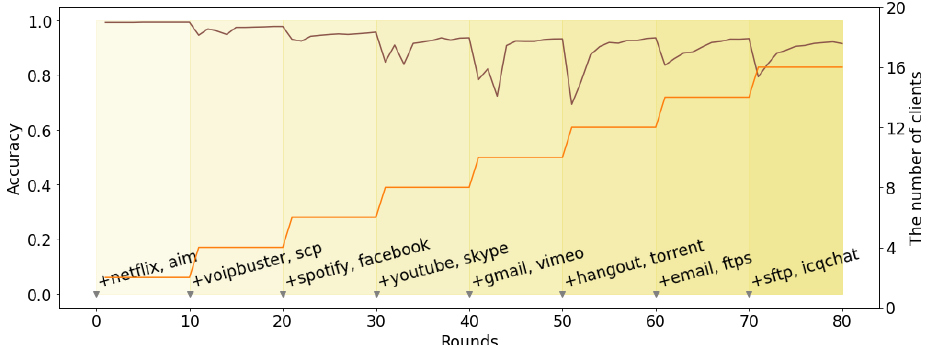
Figure 12. Accuracy of FLIC with dynamic clients and classification labeling